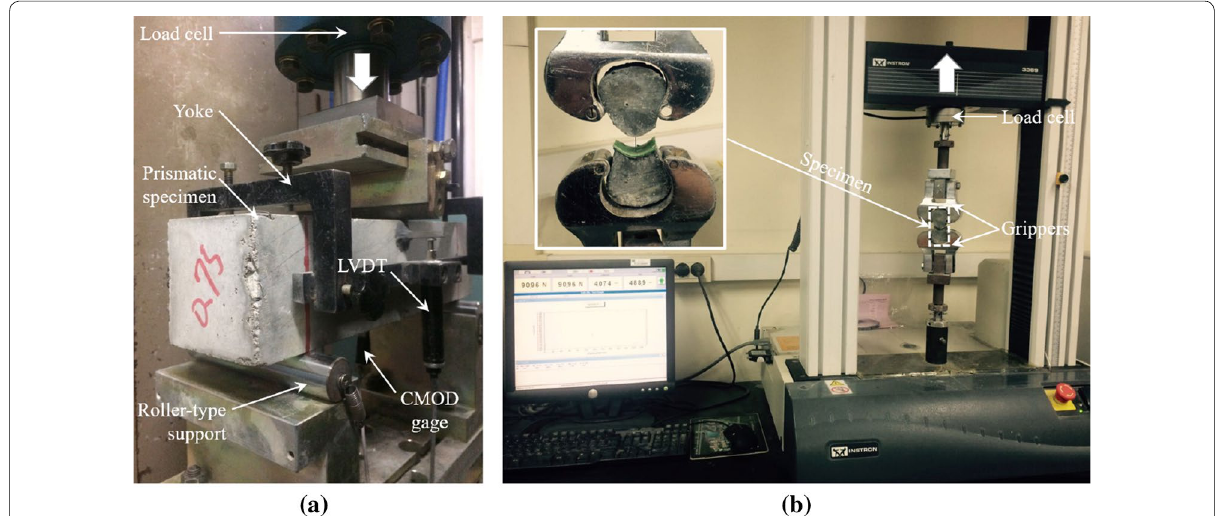
Fig. 2 Mechanical test setup; a three‑point bending test for notched specimen, and b single fiber pullout test.